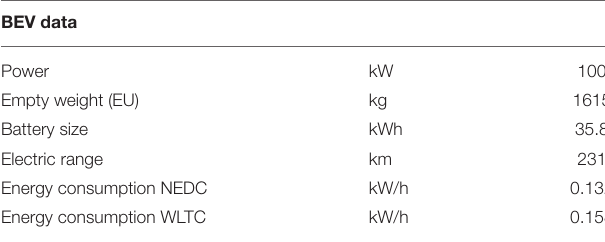
TABLE 10 | BEV data according to type approval (Matzer et al., 2019).